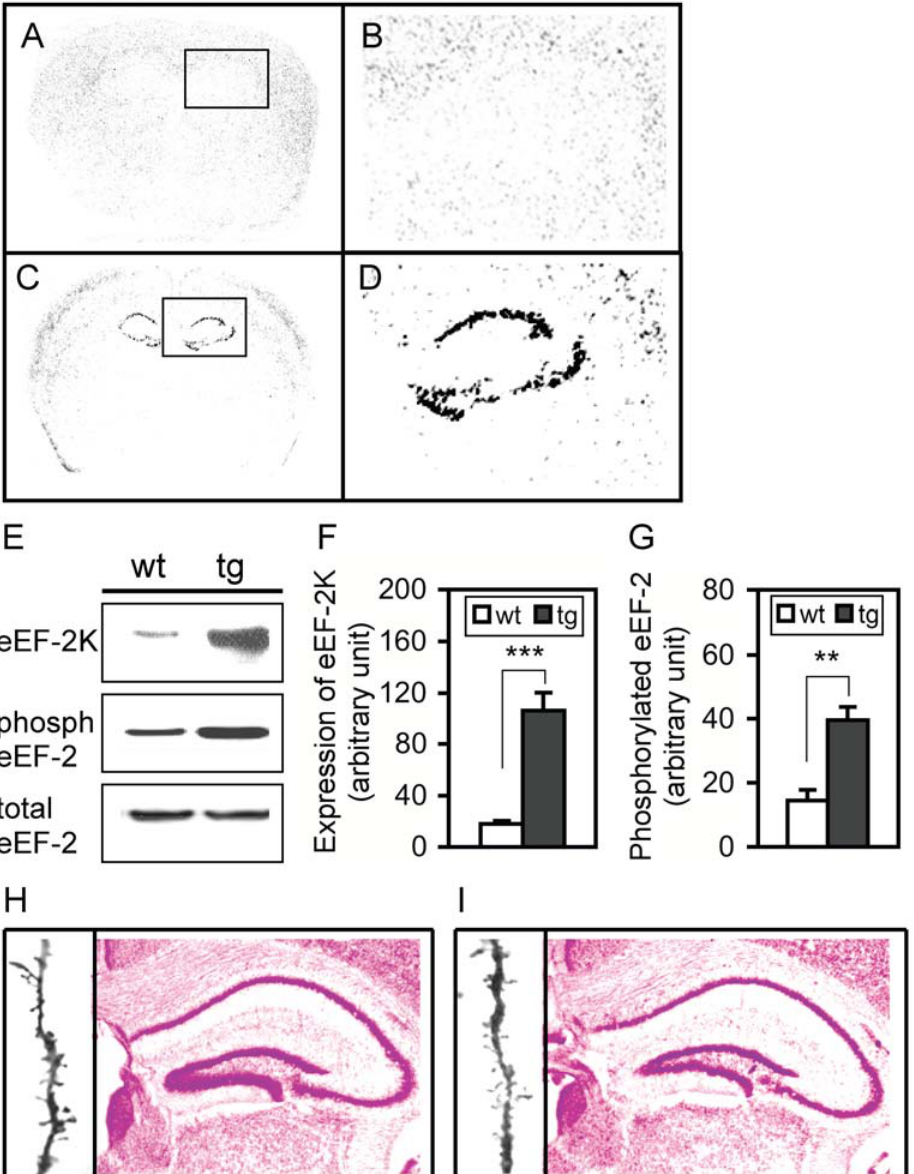
Figure 4. Generation of hip-eEF-2K-tg mice. A-D in situ hybridization showing the expression of the eEF-2K transgene in wild-type (A) and hip- eEF-2K-tg mice (C) or a higher magnification in wild-type (B) and hip-eEF-2K-tg mice (D). Exclusive expression of the transgene mRNA was found in the CA1, CA3, and dentate gyrus, but not the CA2 region. E . Representative Western blots showing the expression of the total eEF-2K (including the endogenous and transgenic eEF-2K; upper panel), phospho-eEF-2 (phosph) (middle panel), and the total eEF-2 (including phospho- and dephospho- eEF-2; low panel) in the hippocampi from wild-type (wt) and hip-eEF-2K-tg (tg) mice. F . Quantitative analysis of the expression of eEF-2K in wt (n=6) and tg mice (n=5). ***, p , 0.001, Student’s t test. G . Quantitative analysis of the expression of phospho-eEF-2 in wt (n=5) and tg mice (n=5). **, p , 0.01, Student’s t test. H and I . Representative microphotography of Nissl staining and Golgi staining in wild-type (h) and hip-eEF-2K-tg mice (i).